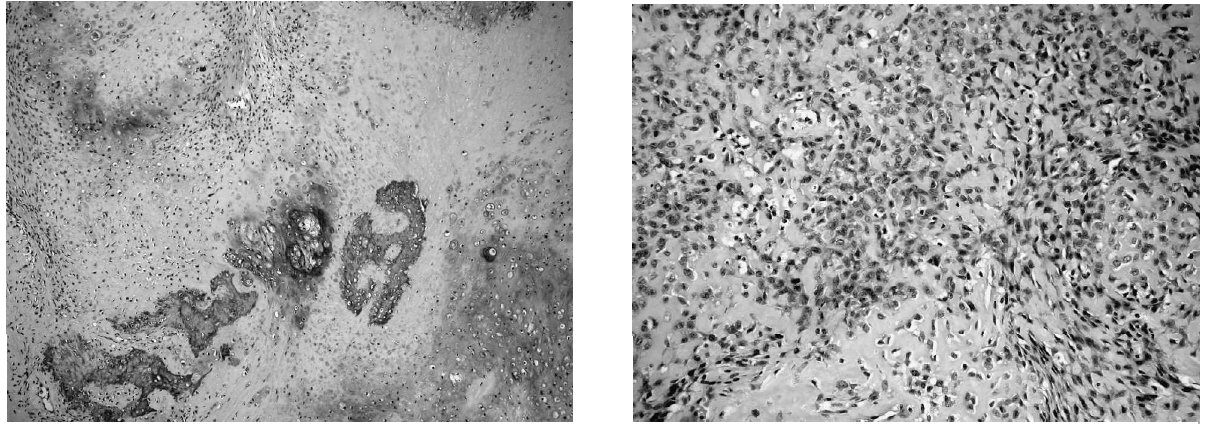
Fig. 3. (a) Lobules of neoplastic cartilage and primitive bone matrix undergoing mineralisation.The tumour is of intermediate grade (H&E stain, (40)). (b) High-grade tumours also showed undifferentiated mesenchymal cells with osteoid matrix deposition (H&E stain,